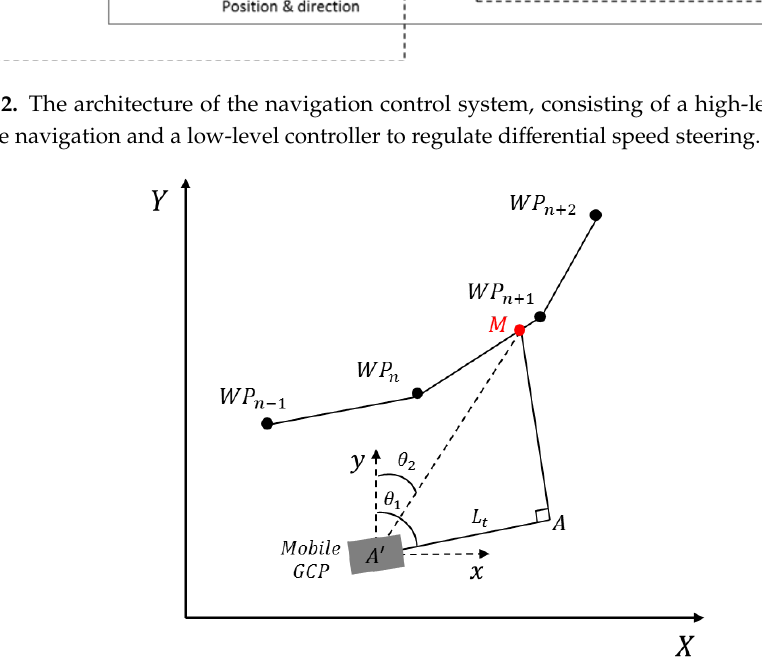
= waypoint; = target 𝑊𝑊𝑊𝑊 𝑀𝑀